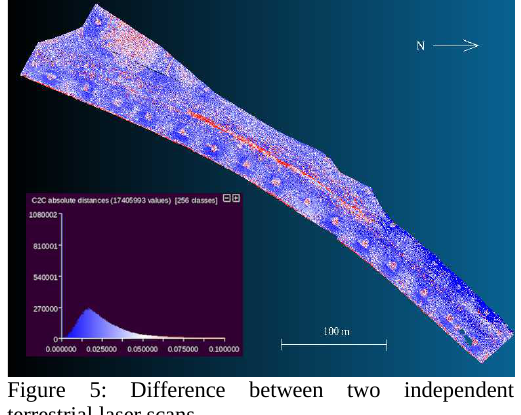
Figure 5: Difference between two independent terrestrial laser scans